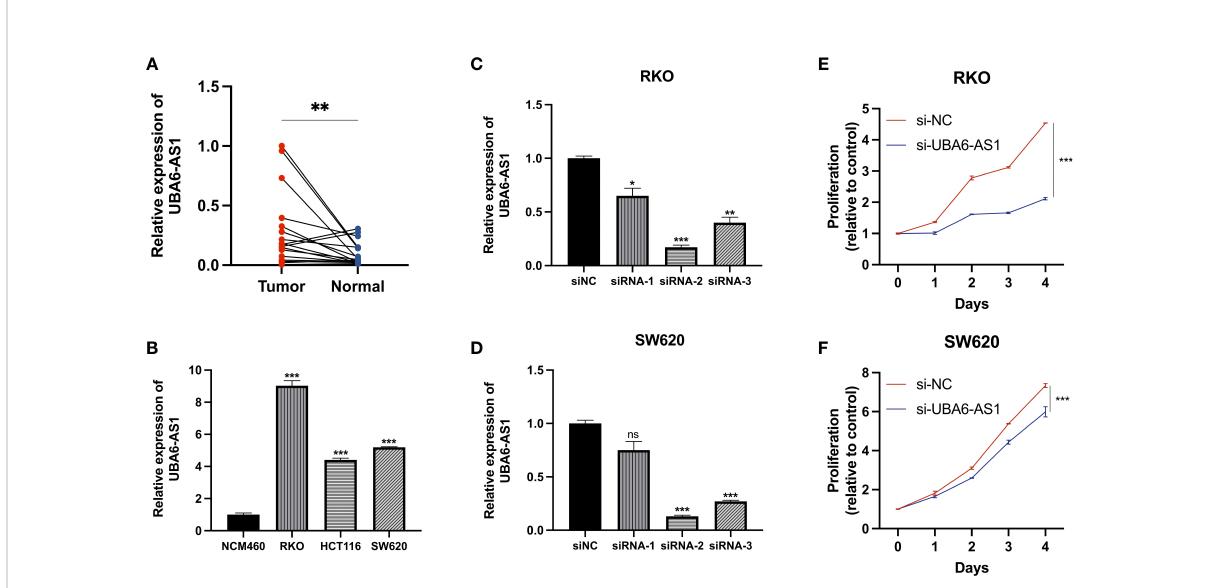
FIGURE 12 Cell function assays. (A, B) Real-time PCR. (C, D) The transfection ef fi ciencies of three siRNAs targeting UBA6-AS1 in RKO cells (C) and SW620 cells (D) . (E, F) CCK-8 assays were conducted after UBA6-AS1 knockdown in RKO (E) and SW620 (F) . ns, Not signi fi cant; *p < 0.05, **p < 0.01, ***p <